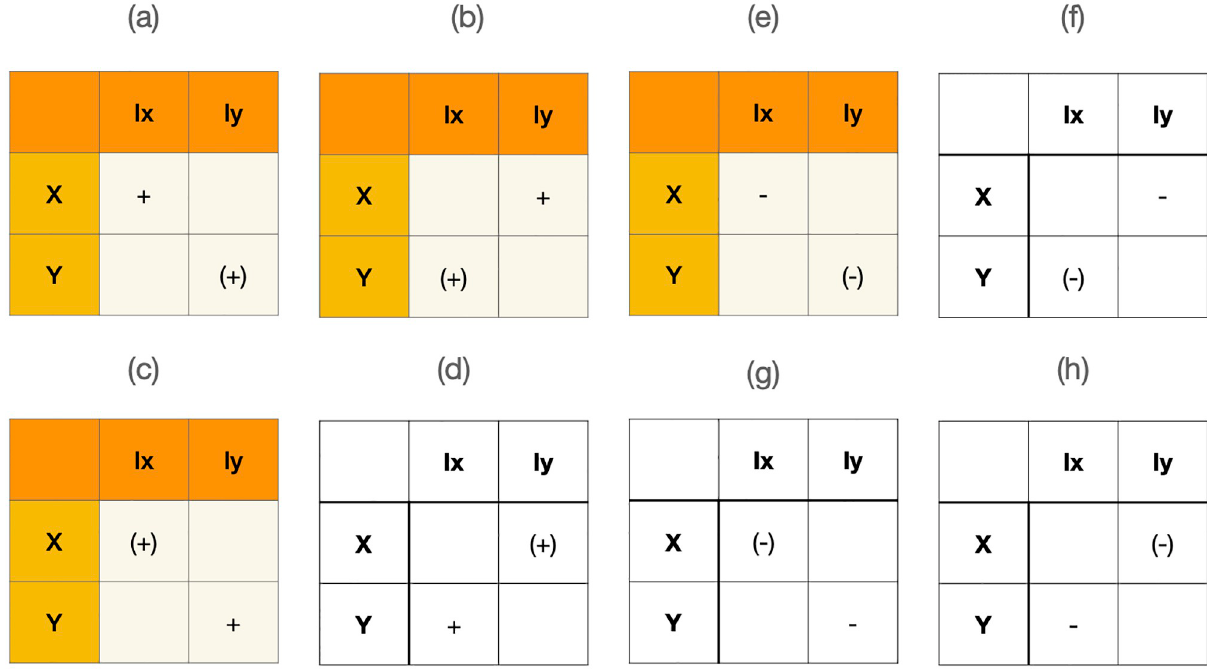
Fig 2. Classification of reinforcement learning rules. The sign of each the entries denotes positive or negative reinforcement acting on weights between a population of agents ( x , y ) and institutional position values ( I x , I y ). Consider (a) as an example: this rule describes positive reinforcement on or y and I . Whereas rule (e) is the dual of rule (a) and only involves negative reinforcement–increases weights mediating interactions between x and I x y in the abundance of agents or position values leads to a reduction in their connecting weights. Generally naked signs +/- indicate the polarity of change to w 1 (the sign to w 2 is the negative of this sign) and parenthetical signs (+/-) are the polarity of the change to w 4 (the sign to w 3 is the negative of this sign). We explore the four rules shaded in orange which we call (a)—the Hebbian Rule; (b)—the Competitive Rule; (c)—the Compensation Rule; (e)— the Least Effort Rule. Rules (a,b,c,e) are all generated through successive 90˚ rotations starting from the identity matrix (a) and rules (d,f,g,h) through successive 90˚ rotations from